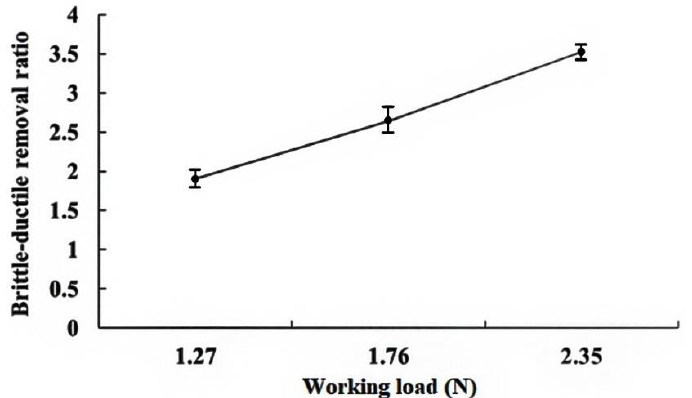
Figure 9. Ratio of brittle fracture to ductile removal rate.